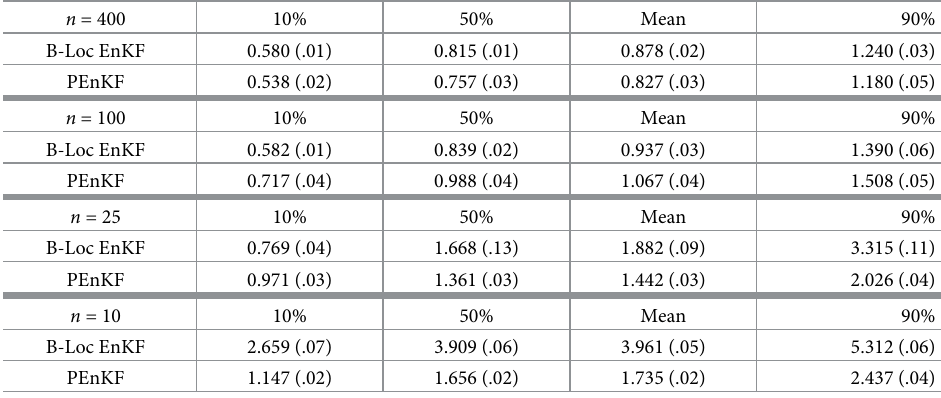
Table 1. Mean, median, 10% and 90% quantile of RMSE averaged over 50 trials. The number in the parentheses is the summary statistics’ corresponding standard